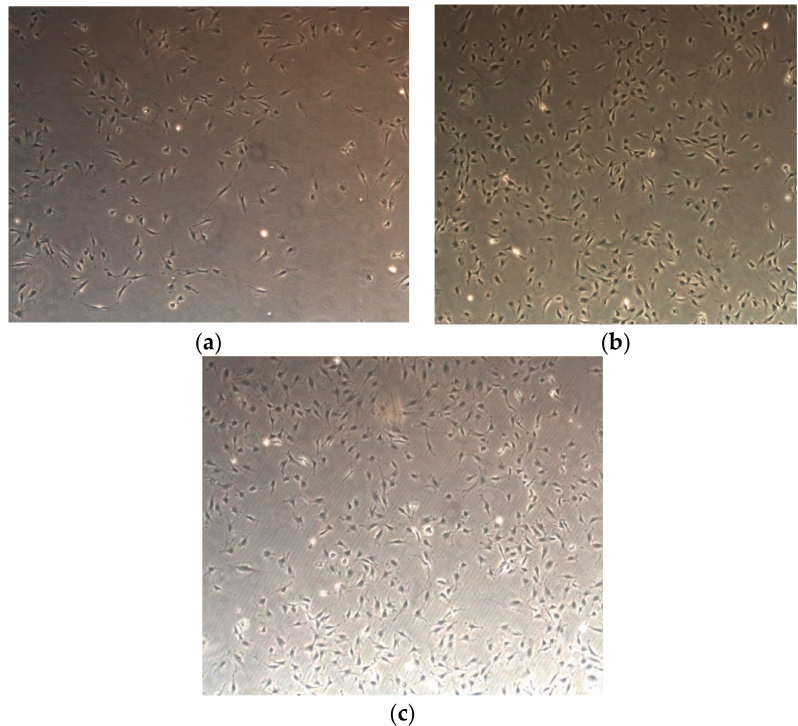
Figure 10. The cells on the culture vessel after ( a ) 24 h, ( b ) 48 h, and ( c ) 72 h of exposure. Magnification 1000 ×